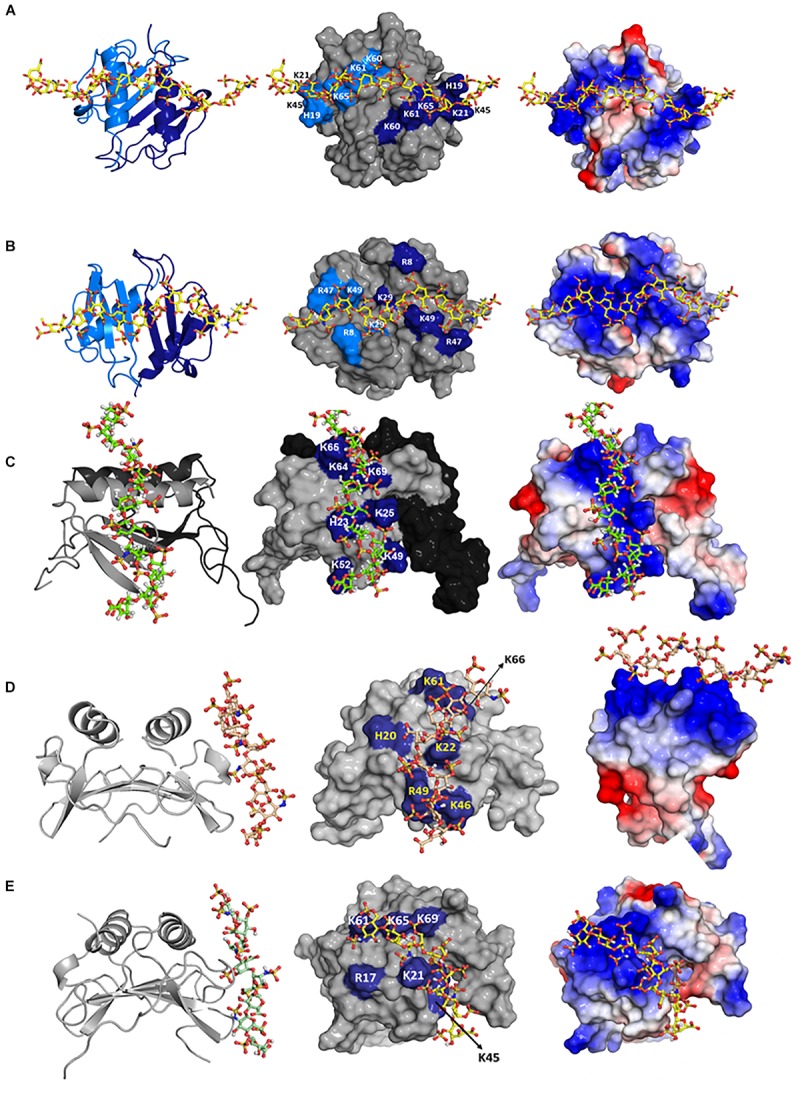
Structural models of heparin bound to (A) CXCL1 α-domain, (B) CXCL1 β-domain, (C) CXCL5, (D) KC/mCXCL1, and (E) MIP2/mCXCL2. Left column: chemokine dimer structures are shown in ribbon presentation and heparin as sticks. Middle column: Heparin binding residues are highlighted on a space-filling model. Right column: Heparin binding residues are shown as the electrostatic surface. In panels (A,B), two monomers of the dimer are shown in light and dark blue (left column) and heparin-binding residues from both monomers are highlighted in light and dark blue (middle column). In panel (C), two monomers of the dimer are shown in gray and black (left and middle columns), and GAG-binding residues are labeled only in the gray monomer. In panels (D,E), both monomers are shown in gray, and only one monomer of the dimer is labeled.